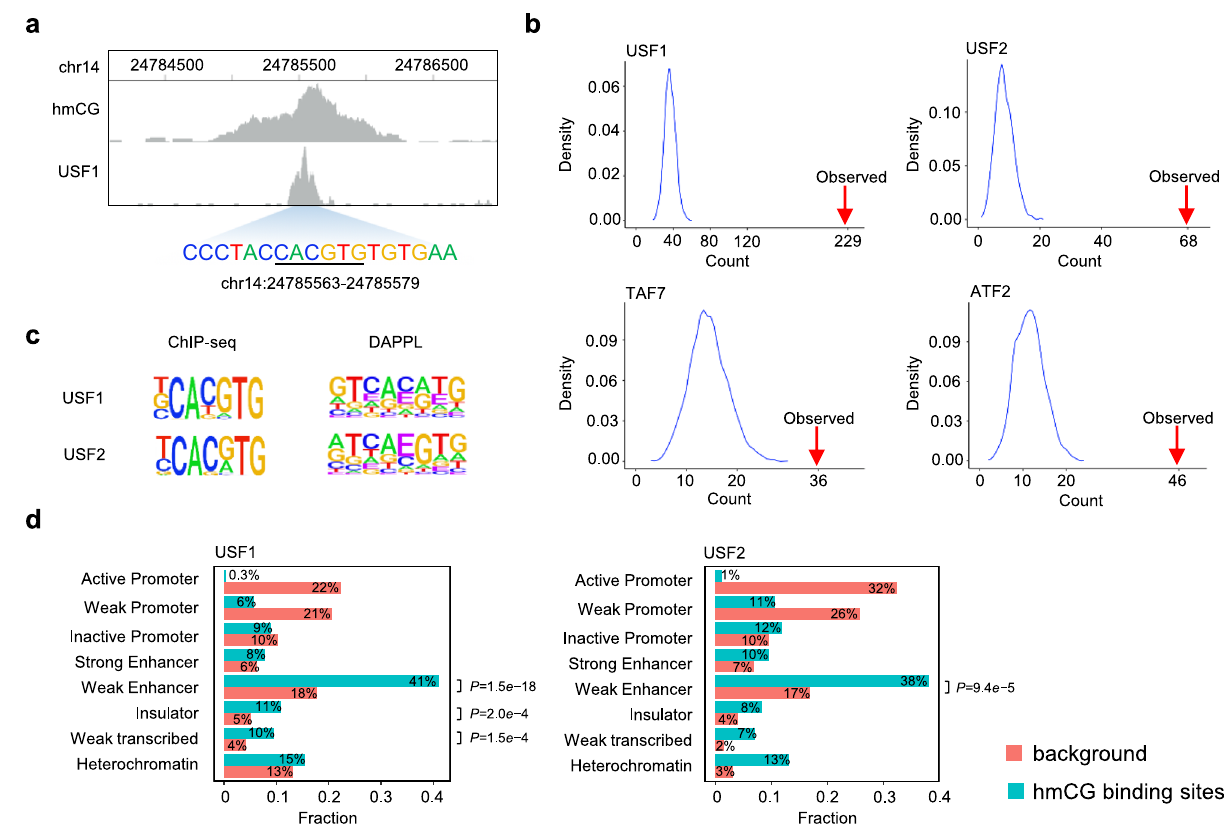
Fig. 7 Potential roles of hmCG readers in human embryonic stem cells. a A genomic region of overlapping hmC and USF1 ’ s ChIP-seq peaks. The identi fi ed USF1 ’ s hmC consensus found in the peak region is underlined. b Statistical signi fi cance of the overlapping peaks. 5000 random assignments of TF ChIP-seq peaks in the genome produced a distribution of the numbers of peaks overlapping with hmC peaks. The observed numbers of the overlapping peaks were indicated with the red arrows for USF1, USF2, TAF7, and ATF2. c Comparison of the consensus sequences obtained with DAPPL and those with sequences in the overlapping peaks. Letter E in the consensus sequences represents modi fi ed cytosine. d Distribution of chromatin states of the overlapping peaks (blue bars) compared with all of the ChIP-seq peaks (red bars). The overlapping peaks of both USF1 and USF2 were enriched in weak enhancer regions with signi fi cant P values. P values were calculated by two-sided Chi-square without adjustments. Source data are provided as a Source Data fi